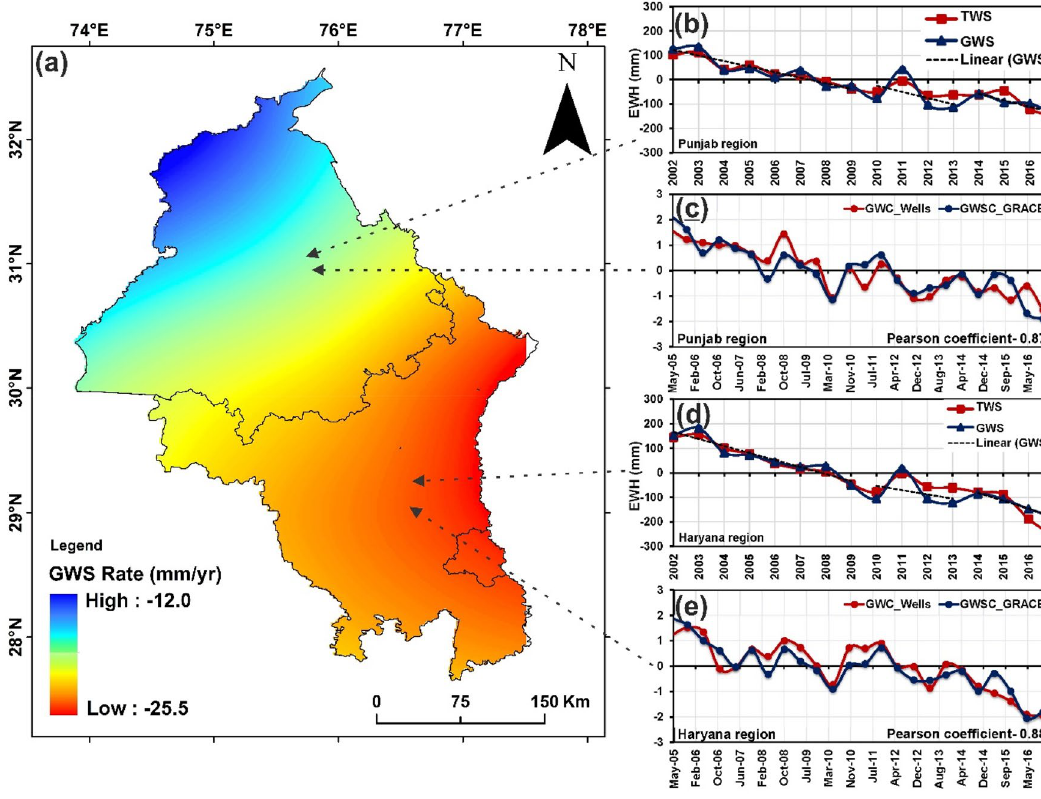
Figure 4. ( a ) The Groundwater storage rate variation in regions of Punjab and Haryana, exhibiting a high rate of depletion in Haryana regions (map is generated using licensed software ArcGIS version 10.6) ( b , d ) Time series plotted on TWS and GWS variation in Punjab and Haryana regions, respectively. ( c , e ) Validating the estimated GWS calculated from the GRACE dataset with the GWC of the well dataset in Punjab and Haryana region, respectively, gving a Pearson coefficient of 0.87 and